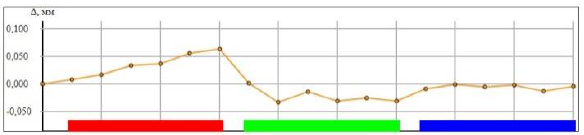
Figure 16. A graph of the results of image processing without prior